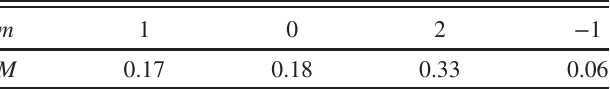
TABLE I. Matrix element M introduced in Eq. (C2), calculated for the first four lowest energy levels of the bilayer quantum dot model presented in Ref. [14], considering U ¼ V ¼ 60 meV and R ¼ 20 nm.